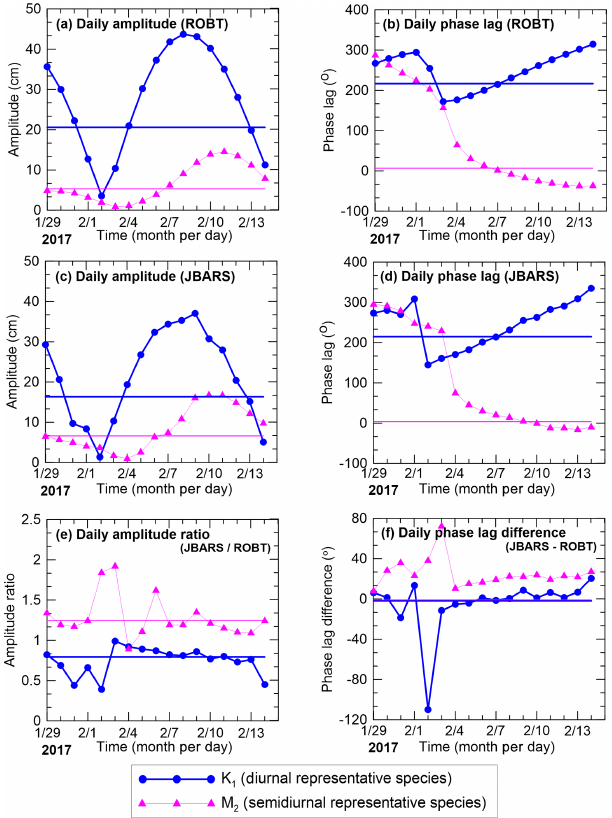
Figure 4. Daily amplitudes (a, c) ; phase lags (b, d) ; amplitude ra- tios (e) ; and phase lag differences (f) of the K 1 and M 2 tides (rep- resentative diurnal and semidiurnal tide species) at ROBT (a, b) and JBARS (c, d) , and between JBARS and ROBT (e, f) , calcu- lated from “daily” slices of the 29 January to 14 February 2017 ROBT tidal predictions and JBARS sea level observations. In addi- tion, thick blue ( K 1 ) and thin pink ( M 2 ) horizontal lines in the pan- els indicate the amplitudes and phase lags derived from harmonic analyses of the entire 369d 2013 ROBT sea level record (a, b) and of the entire 17d 2017 JBARS sea level record (c, d) , along with their amplitude ratios and phase lag differences (e, f)